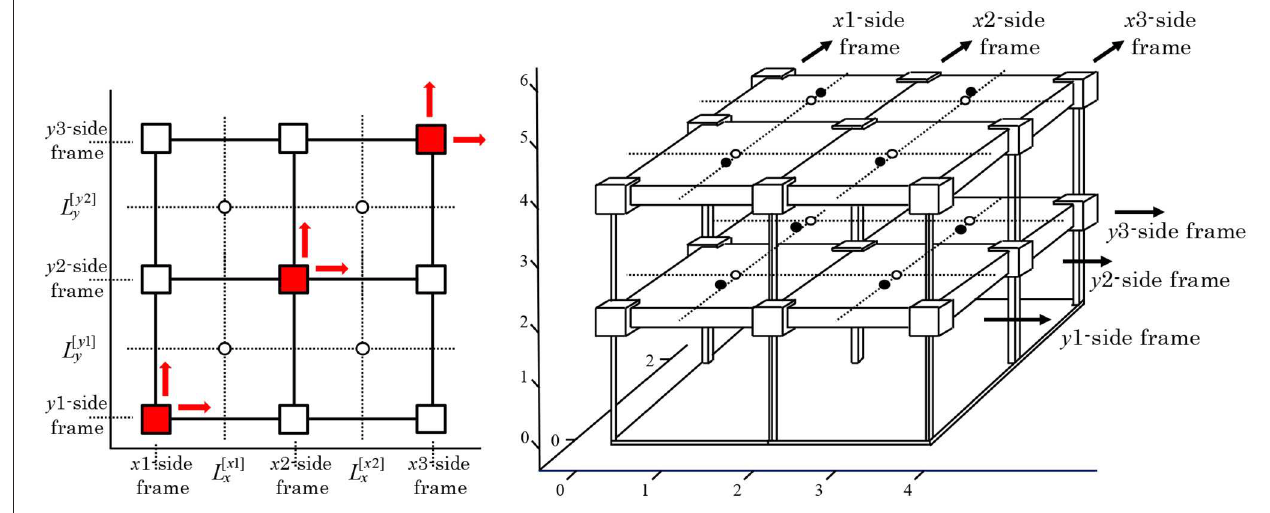
FIGURE 4 | 2-story 2-span three-dimensional building frame.